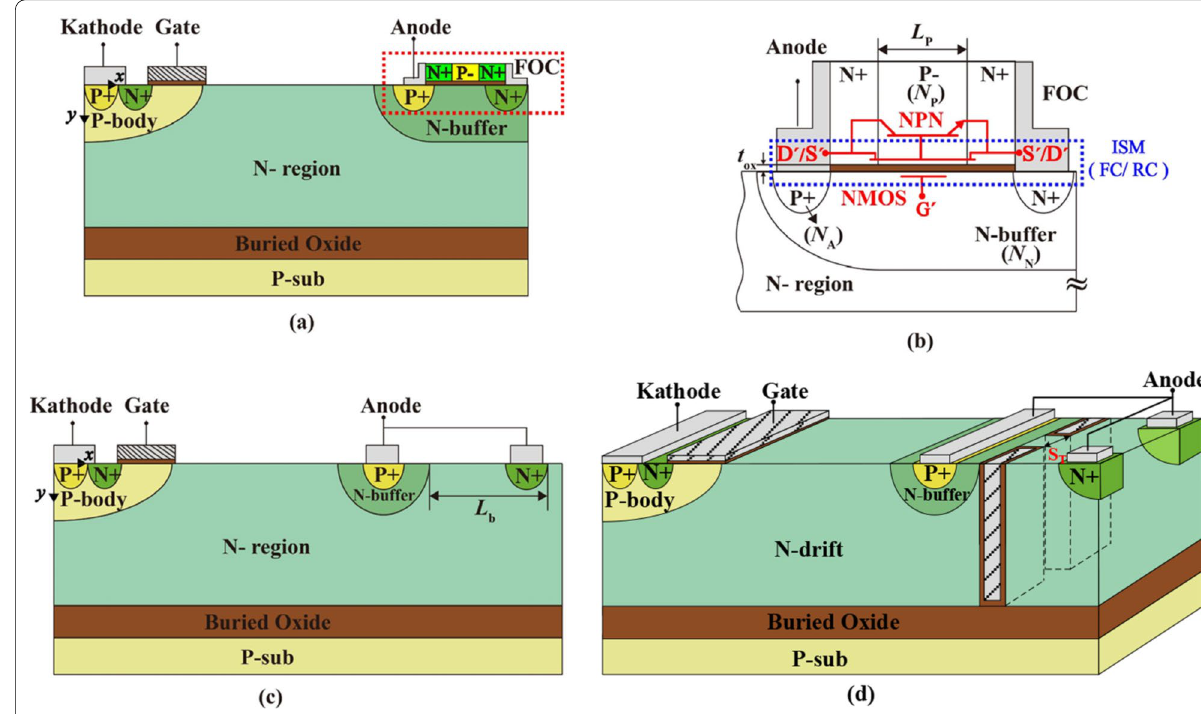
Fig. 1 a Schematic cross section of the ISM RC-LIGBT; b zoomed-in schematic cross section of the anode side; schematic cross section of c SSA LIGBT and d STA